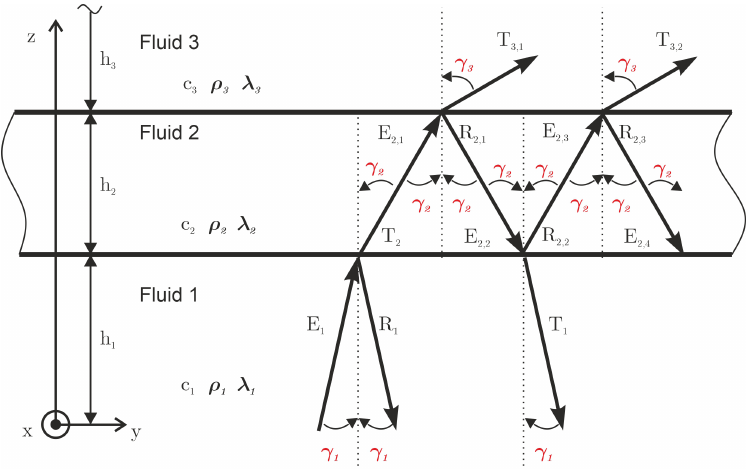
Figure 5. Schematic representation of the 3-layer fluid model. Depicted are the incident E 1 , reflected R n , m , and transmitted T n , m waves at fluid–fluid interfaces. n is the number of interfaces, and m is the number of interactions (example: R 2,3 is the third reflection in the fluid at Interface 2). h n is the height of the fluid layer; ρ n is the density; λ n is the wavelength.